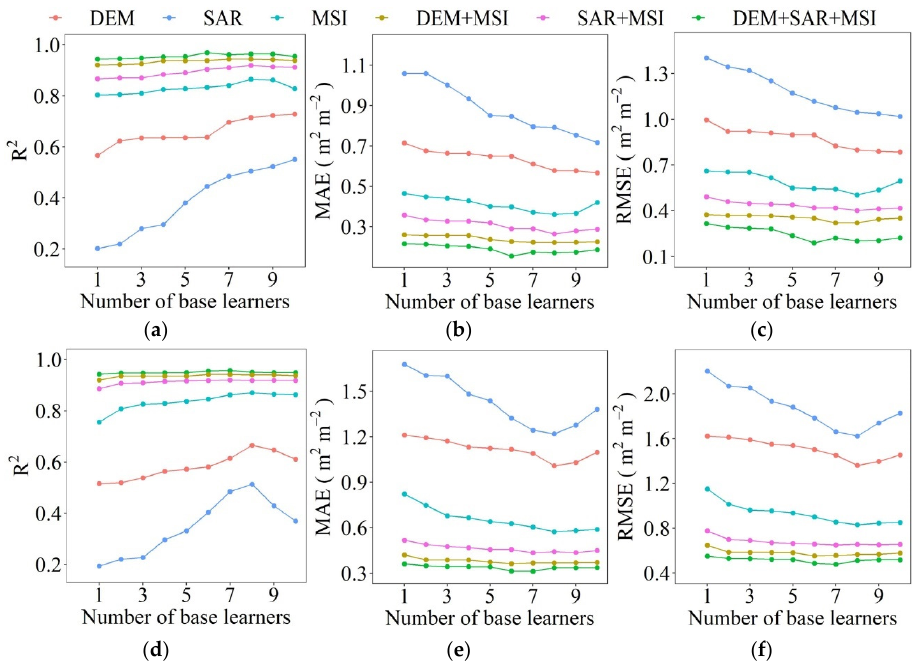
Figure 4. Effects of the number of base learners (NBL) in the SL models on forest LAI estimation in ( a – c ) Xingguo and ( d – f ) Gandong. For the inputs of the DEM, SAR, MSI, DEM + MSI, SAR + MSI, and DEM + SAR + MSI variables, the validation indices of SL models predicting the LAI in Xingguo: the R 2 im- proved by 173%, 335%, 24%, 23%, 23%, and 21%, respectively; the MAE decreased by 51%, 49%, 66%, 67%, 66%, and 71%, respectively; and the RMSE decreased by 44%, 40%, 61%, 62%, 59%, and 64%, on average, respectively, compared to individual ML models (Table 5). Similarly, the validation indices of the SL model for predicting the LAI in Gandong: the R 2 improved by 311%, 492%, 21%, and 19%, respectively; the MAE decreased by 41%, 46%, 66%, 65%, 67%, and 68%; and the RMSE decreased by 34%, 39%, 59%, 58%, 57%, and 59%, on average, respectively. Overall, the SL models achieved higher prediction accuracy than the ten individual ML models. This indicates that the SL model fits better than the individual ML model regardless of the input variables, and therefore, SL has good pro- spects for retrieving the forest LAI. Among the three types of predictor variables, the MSI derivatives obtained a higher prediction accuracy than the SAR and DEM data. For example, when predicting the LAI in Xingguo, the validation indices for the MSI variables were as follows: the R 2 , the MAE, and the RMSE in the range of 0.64 to 0.95, 0.23 to 1.01, and 0.34 to 1.28, respectively, while those for the DEM variables were as follows: the R 2 , the MAE, and the RMSE in the range of 0.20 to 0.72, 0.56 to 1.27, and 0.79 to 1.52, respectively, and those for the SAR variables were as follows: the R 2 , the MAE and the RMSE in the range of 0.11 to 0.66, 0.60 to 1.32, and 0.89 to 1.64, respectively. For the LAI estimation, overall, the DEM data yielded better predictions than SAR. For all the models, the incorporation of the SAR and MSI data improved the predic- tion accuracy (Table 5). There are overestimations and underestimations found for some of the sample plots for the single-source models both in Xingguo and Gandong (Figures 5 and 6). Given the same model, compared with those from the inputs of single-source data, the lower uncertainty was obtained by using the dual- or triple-source data. Specifically,